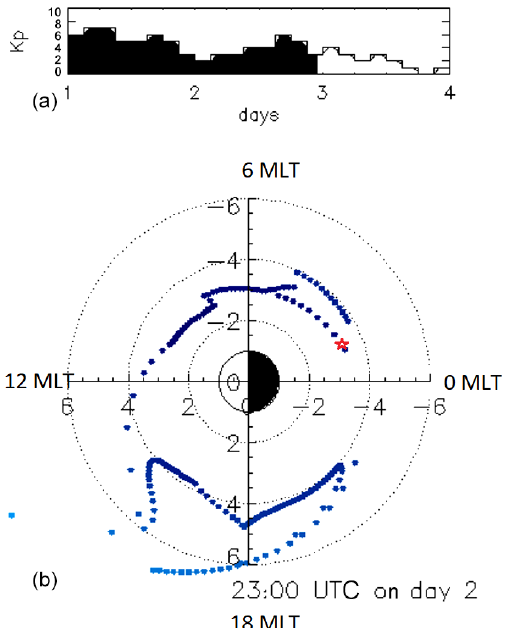
Figure 10. The Kp index (a) and the simulated plasmapause loca- tion (b) in the geomagnetic equatorial plane (marked by all of the blue dots) at 23:00UTC on 27 August 2018 from the CCMC web- site. The red star represents the conjugate location of Pc1 waves observed by the CSES in the Southern